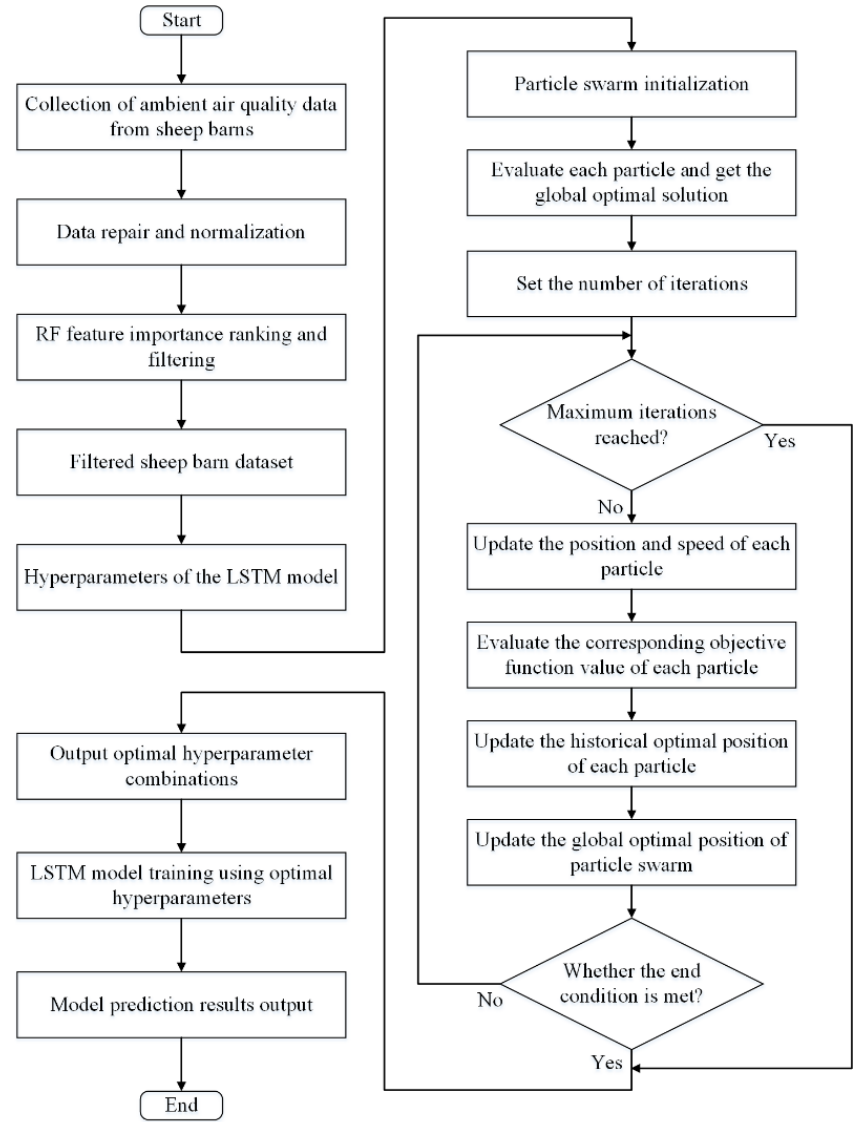
Figure 4. Flowchart of RF-PSO-LSTM prediction model.